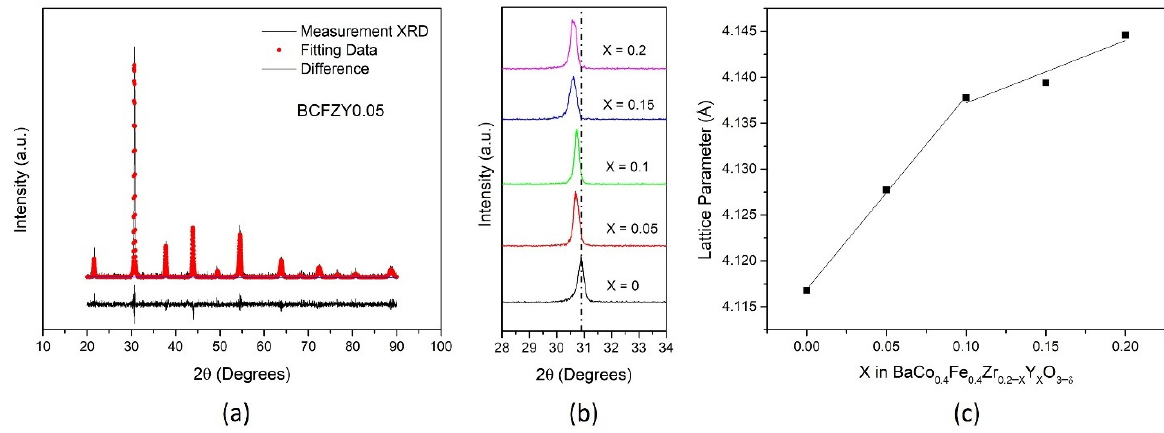
Figure 1. Structural data for ( a ) BCFZY0.05 with Rietveld refinement, ( b ) all compositions for (110) plane, and ( c ) lattice parameter calculated from XRD.